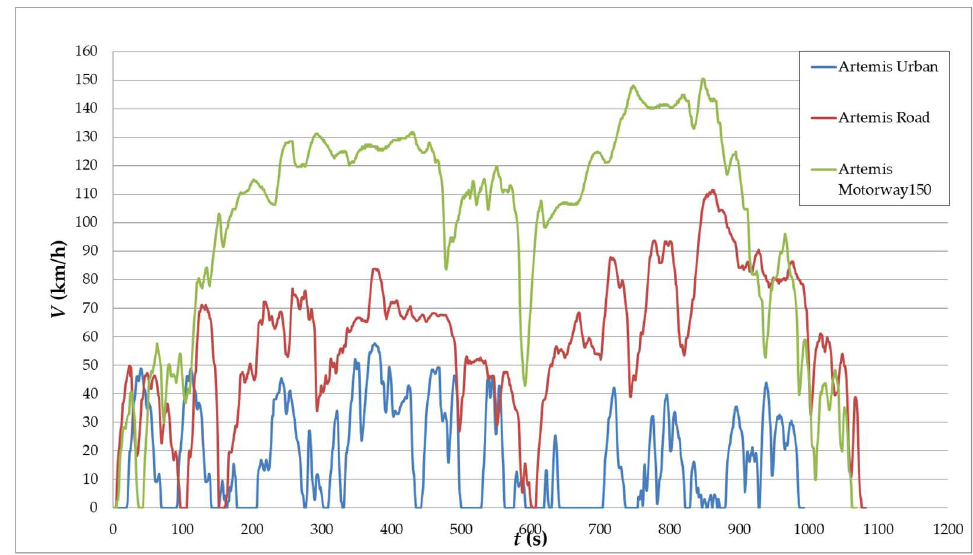
Figure 10. Vehicle speed waveforms for Artemis driving cycles.